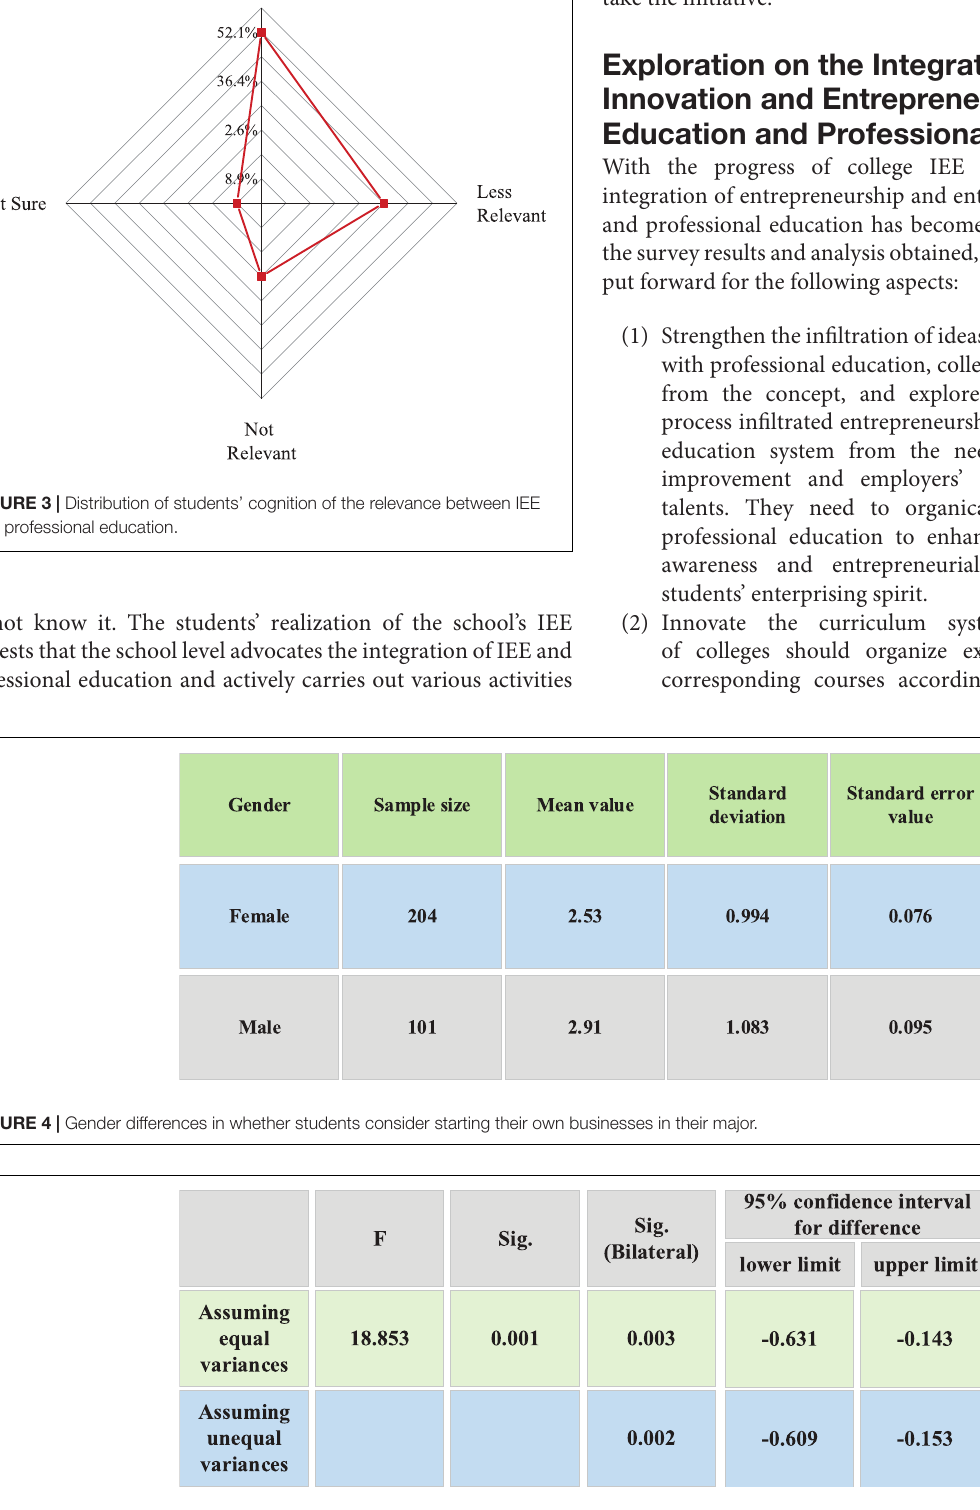
FIGURE 5 | Test results of independent